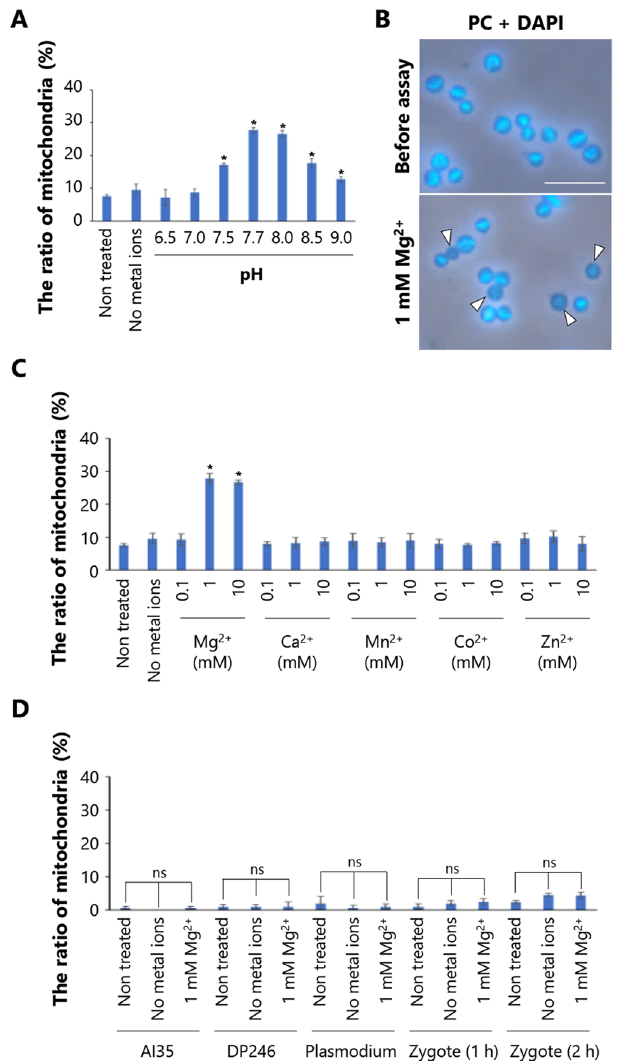
Figure 3. Characterization of DNase in isolated mitochondria using a semi-in vitro assay. ( A ) Effect of pH on the digestion of mt-nucleoids. The isolated mitochondria from zygotes at 3 h after plating were incubated under various pH levels (6.5–9.0) without metal ions or in the presence of five divalent ions: Mg 2+ , Ca 2+ , Mn 2+ , Zn 2+ , and Co 2+ and then the lengths of the mt-nucleoid were measured. The ratios of mitochondria with mt-nucleoids < 0.5 μm before (non treated) or after incubation were indicated; n = 100–104 mitochondria. Error bars represent mean ± SD from three independent experiments. Significance difference was tested by Dunnett’s test. * P < 0.05. ( B ) Observation of change in the length of mt-nucleoids in isolated mitochondria during incubation. The isolated mitochondria from zygotes at 3 h after plating were incubated in the presence of 1 mM Mg 2+ at pH 7.7. The mt-nucleoids in the isolated mitochondria were observed ( a ) before, and ( b ) after incubation with DAPI staining. Arrowheads indicated the digested mt-nucleoids. Scale Bar = 5 μm. ( C ) Effect of metal ions on the digestion of mt-nucleoids. The isolated mitochondria from zygotes at 3 h after plating were incubated without metal ions or in the presence of various concentrations of Mg 2+ , Ca 2+ , Mn 2+ , Co 2+ , or Zn 2+ at pH 7.7, and then the lengths of the mt-nucleoid were measured. The ratios of mitochondria with mt-nucleoids < 0.5 μm before or after incubation were indicated; n = 98–102 mitochondria. Error bars represent mean ± SD from three independent experiments. Significance difference was tested by Dunnett’s test. * P < 0.05. ( D ) The semi-in vitro assay using the isolated mitochondria from AI35, DP246, plasmodium, and cells at 1 h and 2 h after plating. The isolated mitochondria from each cell were incubated without metal ions or in the presence of 1 mM Mg 2+ at pH 7.7, and then the lengths of the mt-nucleoid were measured. The ratios of mitochondria with mt-nucleoids < 0.5 μm before or after incubation were indicated; n = 97–111 mitochondria. Error bars represent mean ± SD from three independent experiments. Significance difference was tested by Dunnett’s test. ns: not